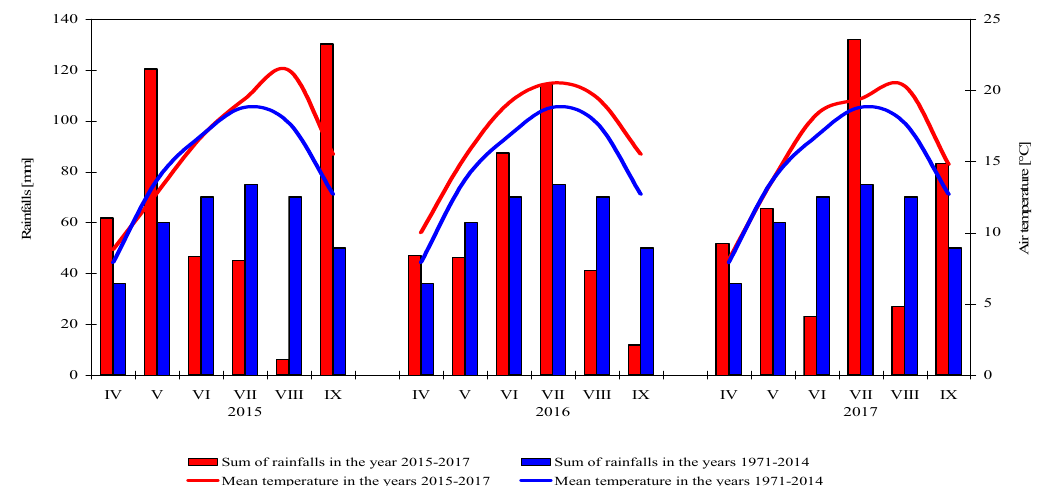
Figure 1. Rainfall and air temperature during the potato growing season in the years 2015–2017, compared with the average long-term rainfall and air temperatures in the years 1971–2014, according to data from the Hydrological and Meteorological Station of the station in Uhnin.